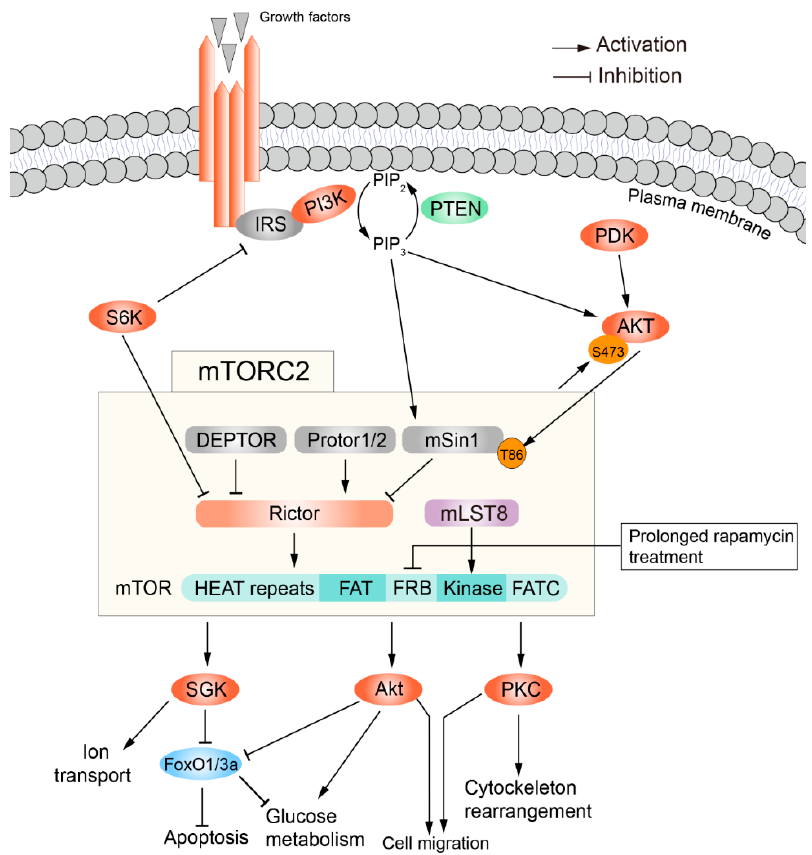
Figure 2. The structures, regulatory mechanism and functions of mTORC2.